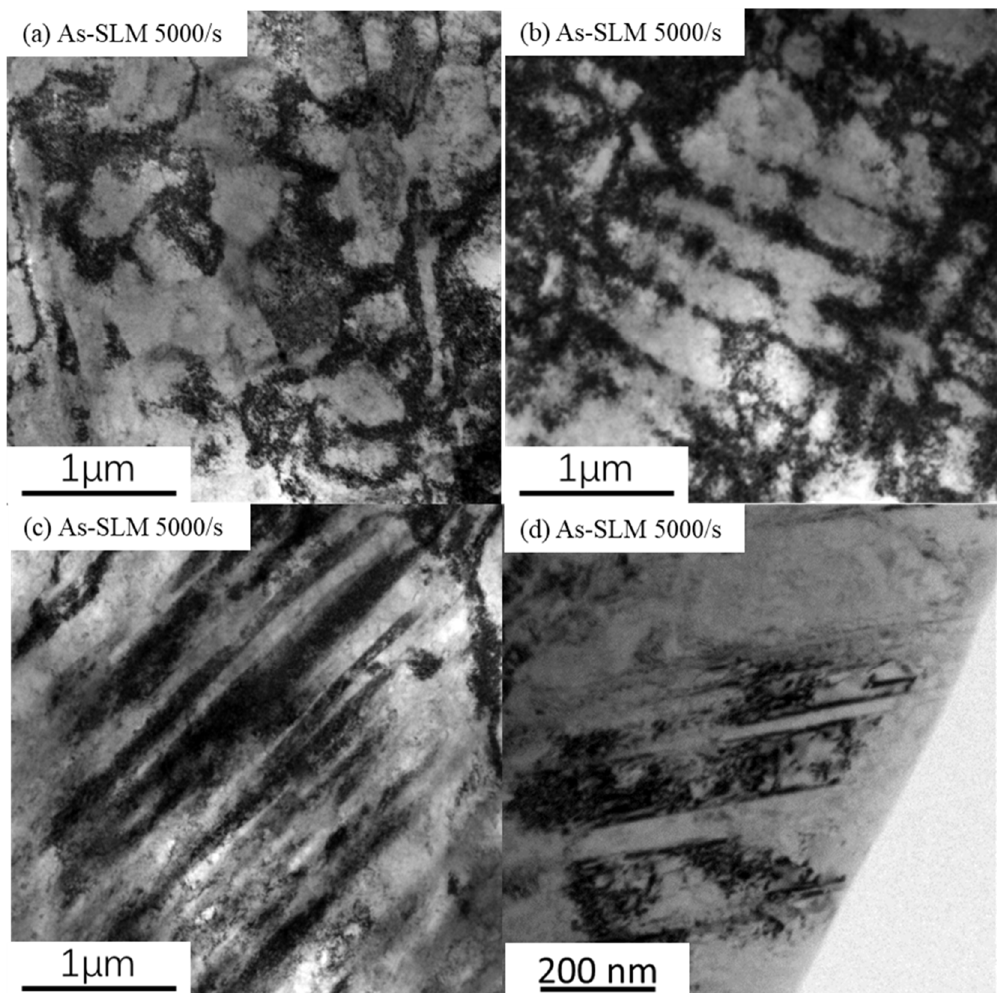
Figure 7. TEM images of the As-SLM specimen deformed at 5000/s. ( a ) The dislocation cell walls partially disappeared. ( b ) High dislocation density in the coarse grain regions. ( c ) Microbands were only observed in the small grain regions. ( d ) Deformation twins.